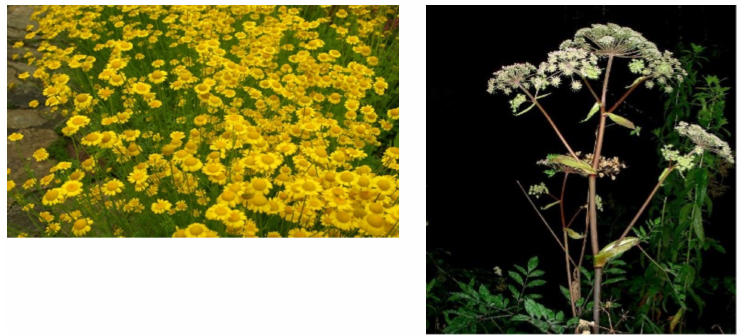
Figure 1. Anthemis tinctoria ( left ) and Angelica sylvestris ( right